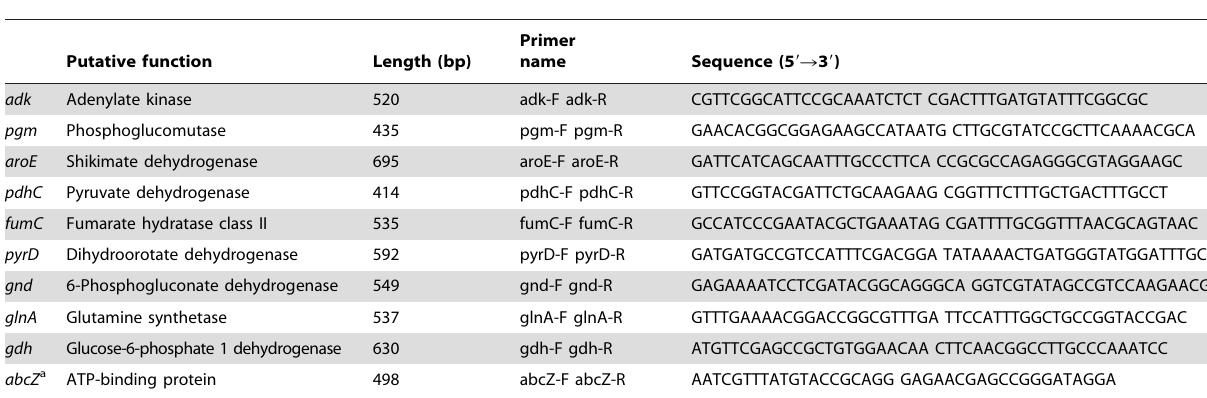
Table 1. Primer pairs used for PCR-s for 10 housekeeping genes of N. gonorrhoeae .